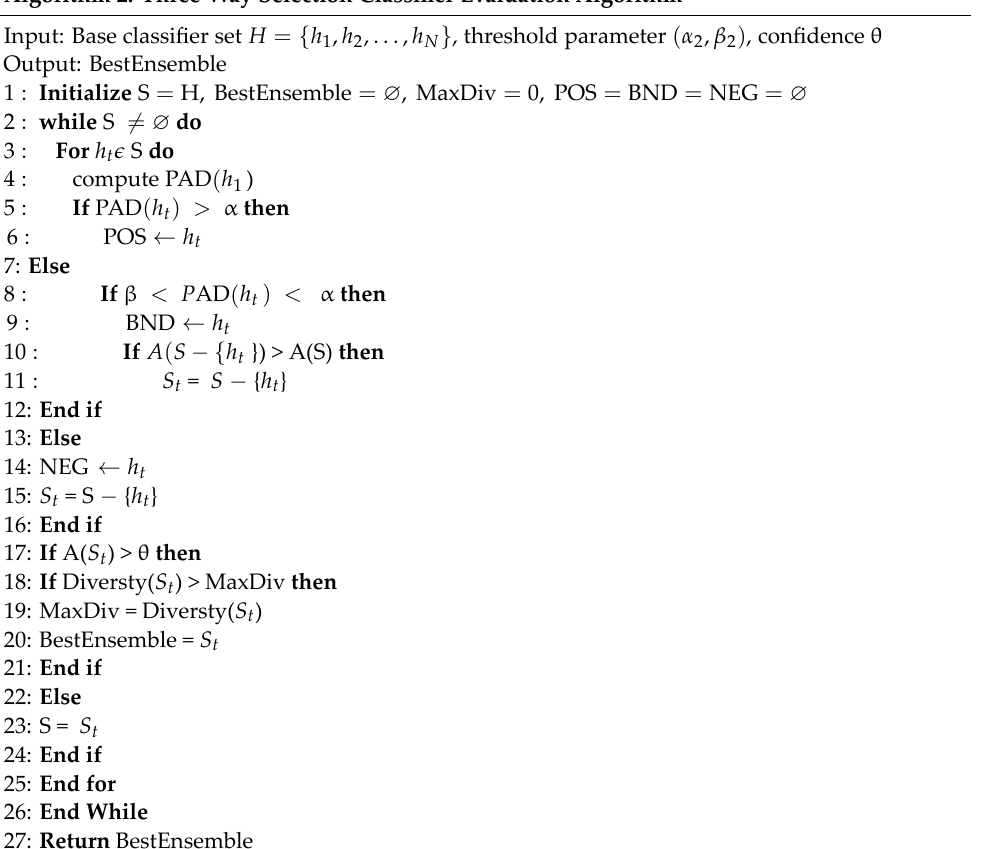
Algorithm 2: Three‑Way Selection Classifier Evaluation